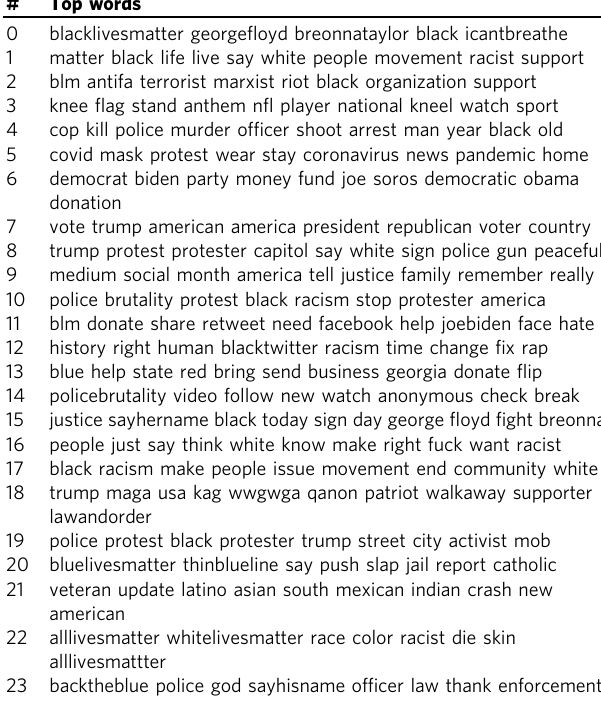
blacklivesmatter george fl oyd breonnataylor black icantbreathe 1 matter black life live say white people movement racist support 2 blm antifa terrorist marxist riot black organization support